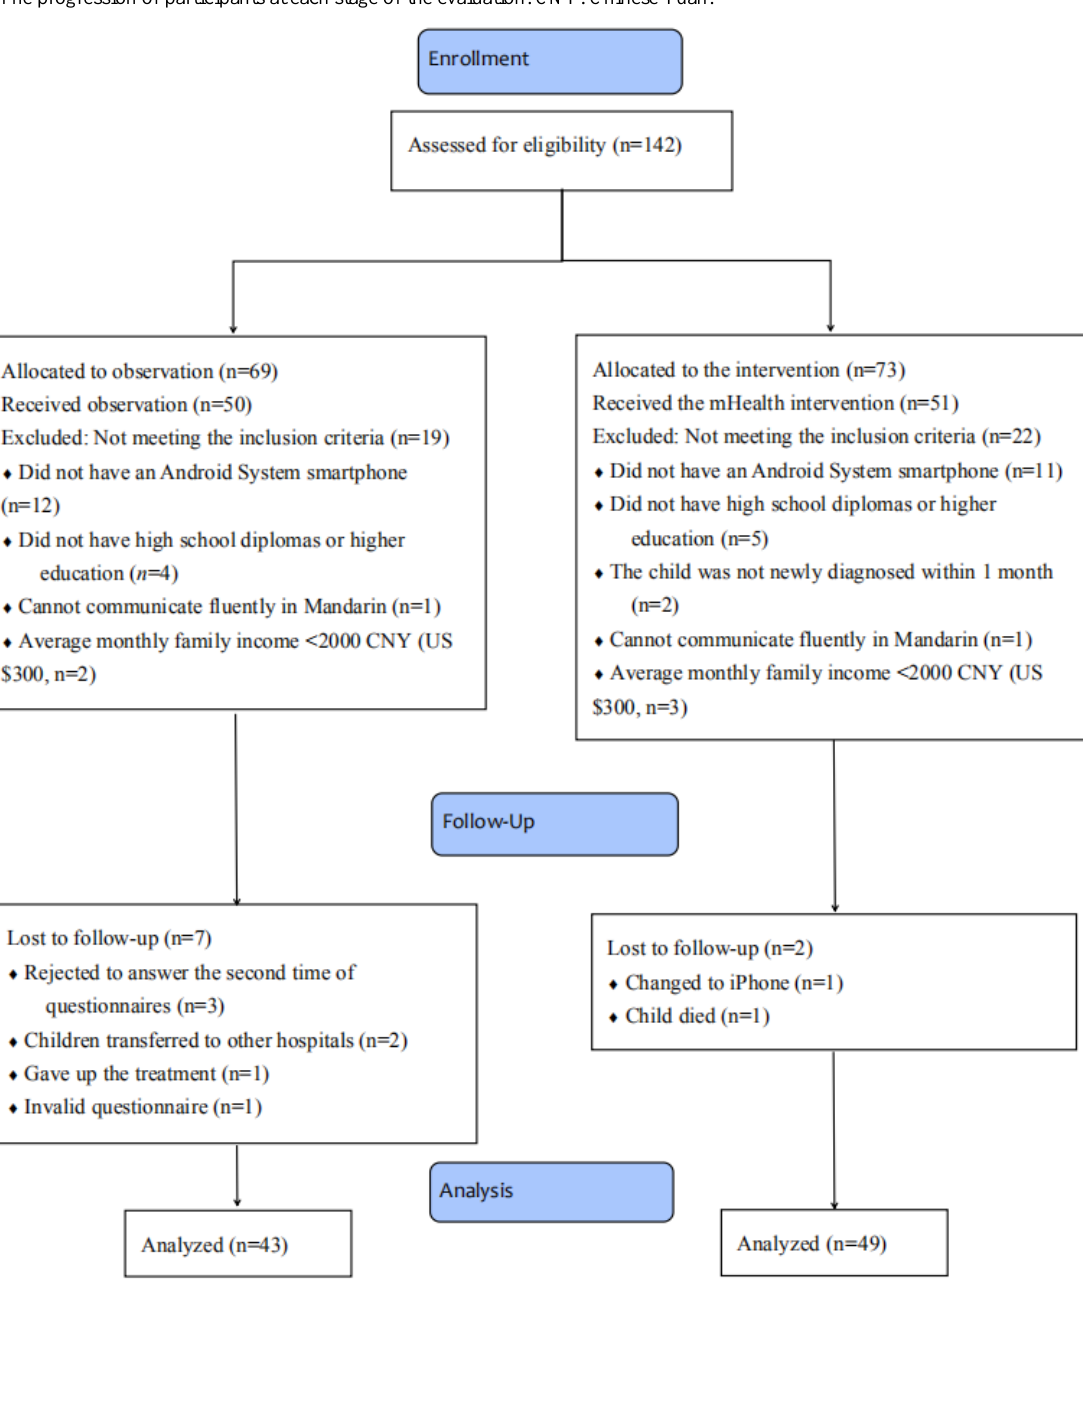
Figure 3. The progression of participants at each stage of the evaluation. CNY: Chinese